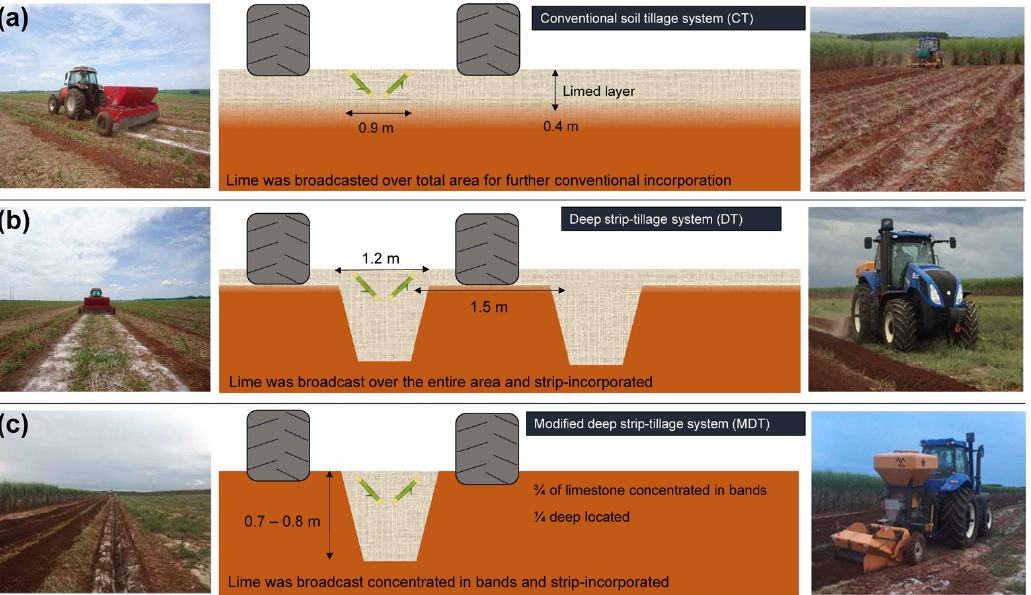
Figure 7. Illustration of the soil tillage systems; ( a ) conventional tillage system, ( b ) deep-strip tillage system, and ( c ) modified deep-strip tillage system, equipment, and the disposition of sugarcane plants.